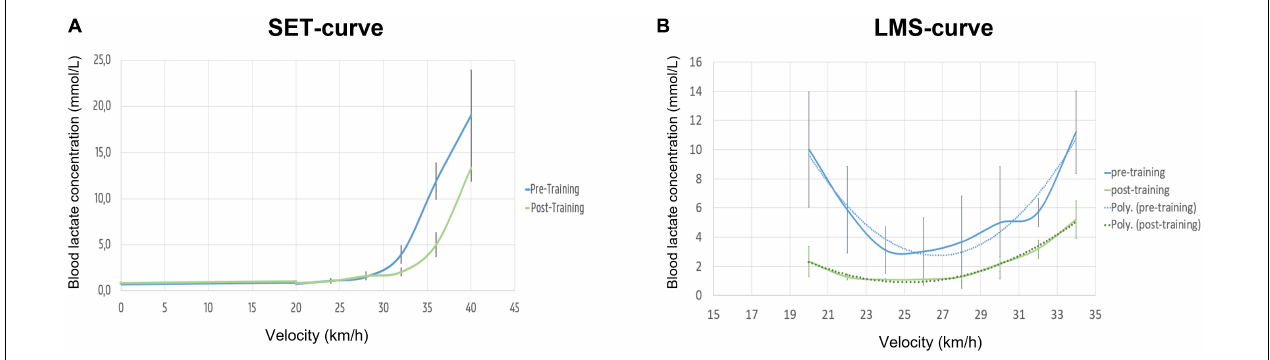
FIGURE 4 | Evolution of velocity vs. blood lactate concentration pre- and post-training ( n = 6 horses). (A) Standardised exercise test curves; (B) lactate minimum speed curves. Poly-, polynomial curve fitting.